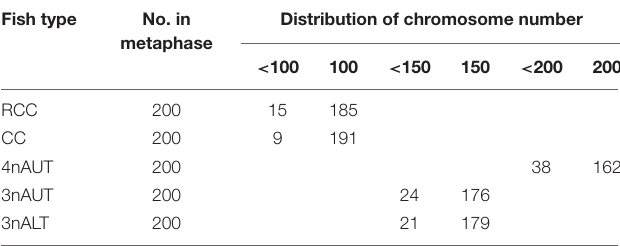
TABLE 5 | Examination of chromosome number in 3nAUT, 3nALT and their parents. Fish type